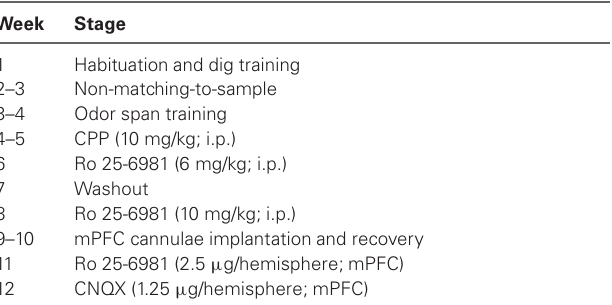
Table 1 | Schedule of treatments during the experiment